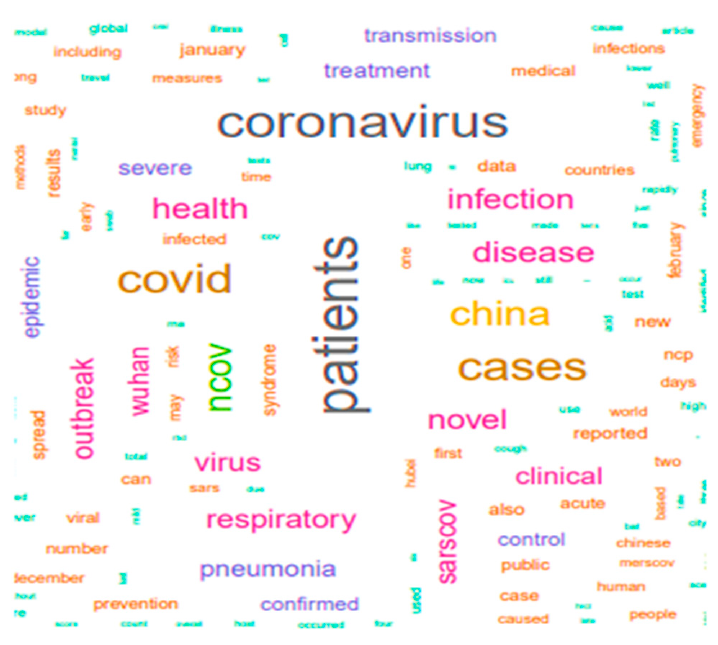
Figure 1. Word cloud of most common search patterns.